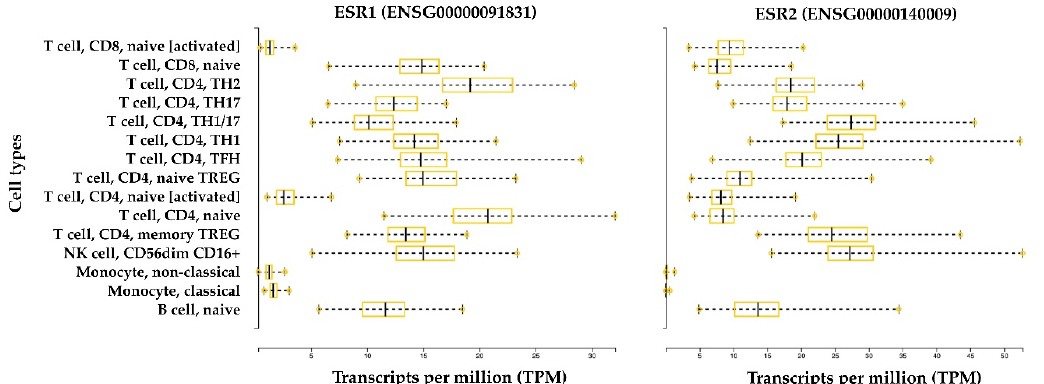
Figure 2. The three main different isoforms of ER α are presented: the full-length 66 kDa ER α (ER α 66), the AF-1 domain-truncated 46 kDa variant of ER α (ER α 46), and a 36 kDa ER α variant (ER α 36) that lacks both AF-1 and AF-2 domains [43–45]. The relative protein levels in different immune system cells are indicated by ++, +, or ND (not detected) [61,65].